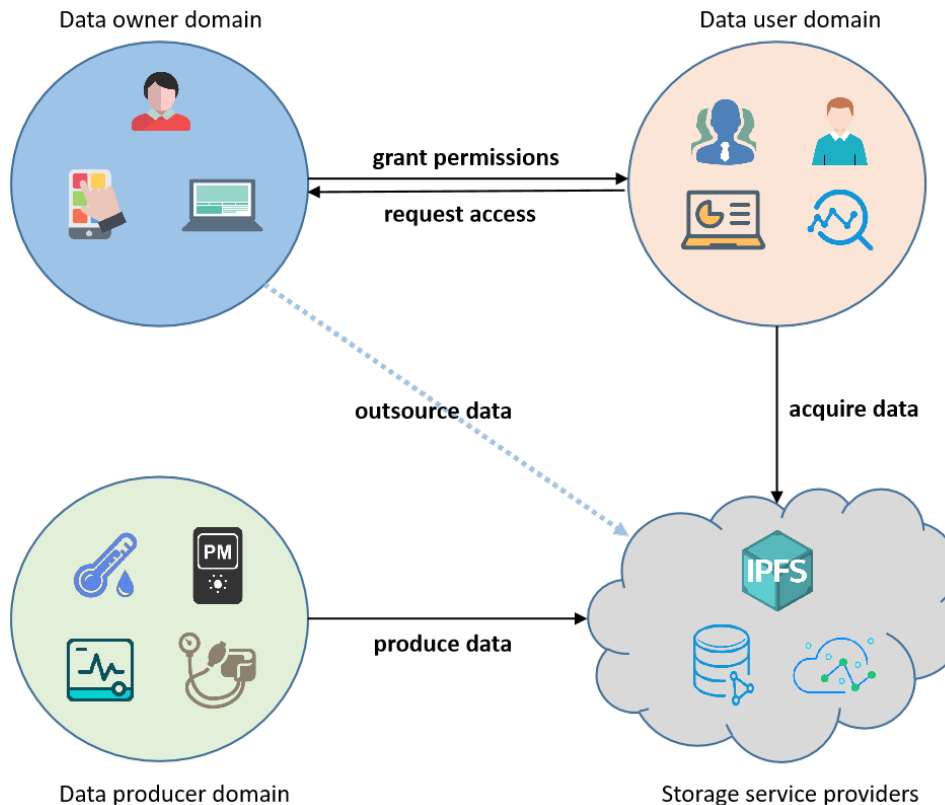
Figure 1. The traditional data-sharing